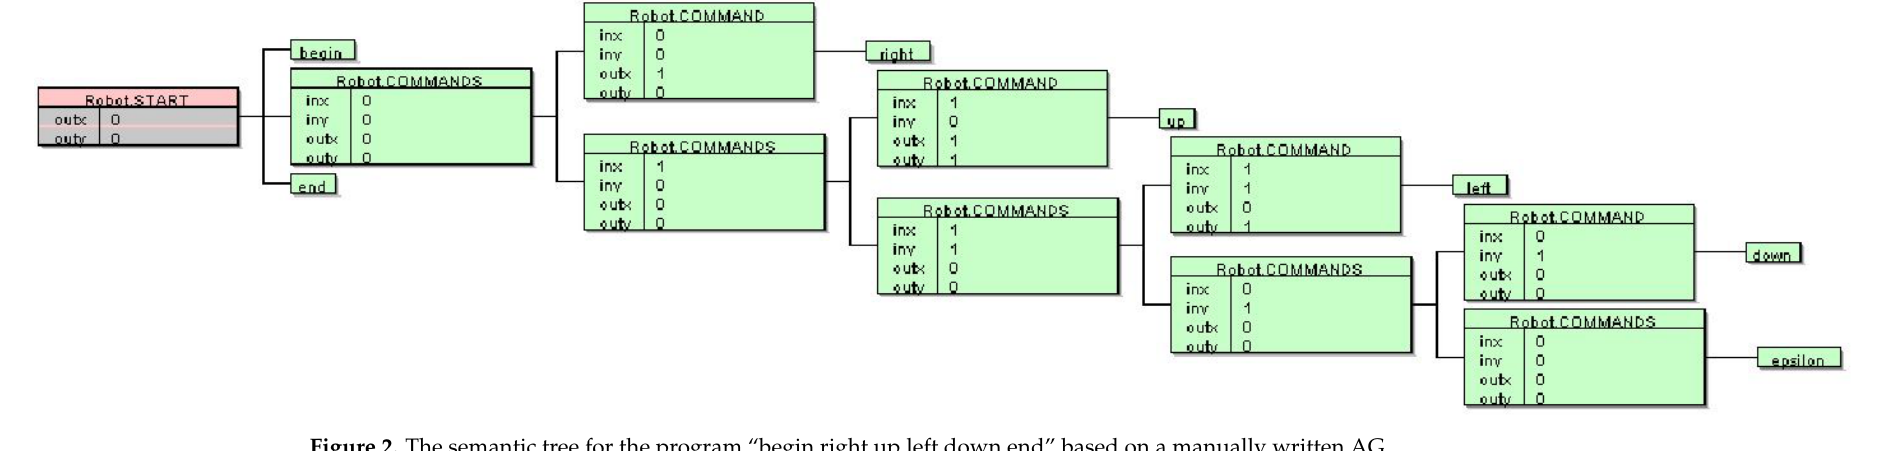
Figure 2. The semantic tree for the program “begin right up left down end” based on a manually written AG.